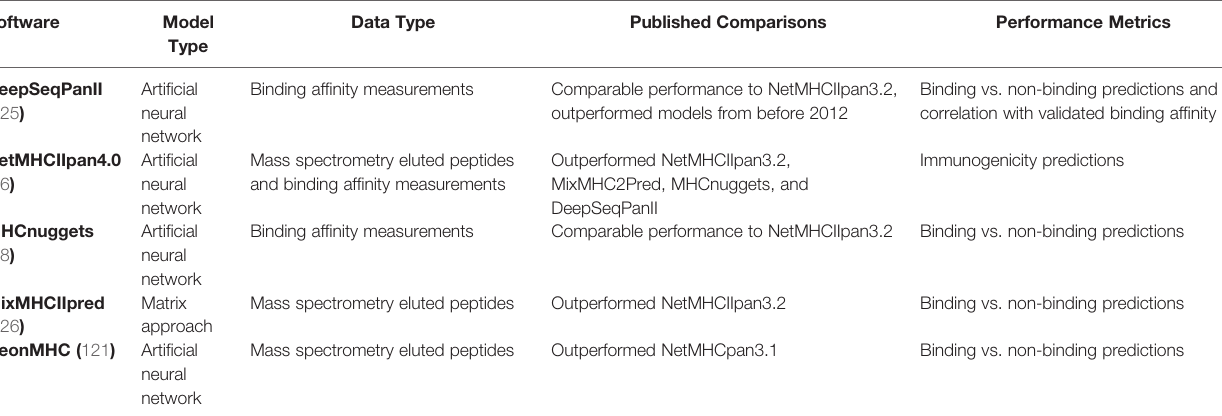
TABLE 5 | Comparison of available neoantigen: MHC class II binding prediction tools.